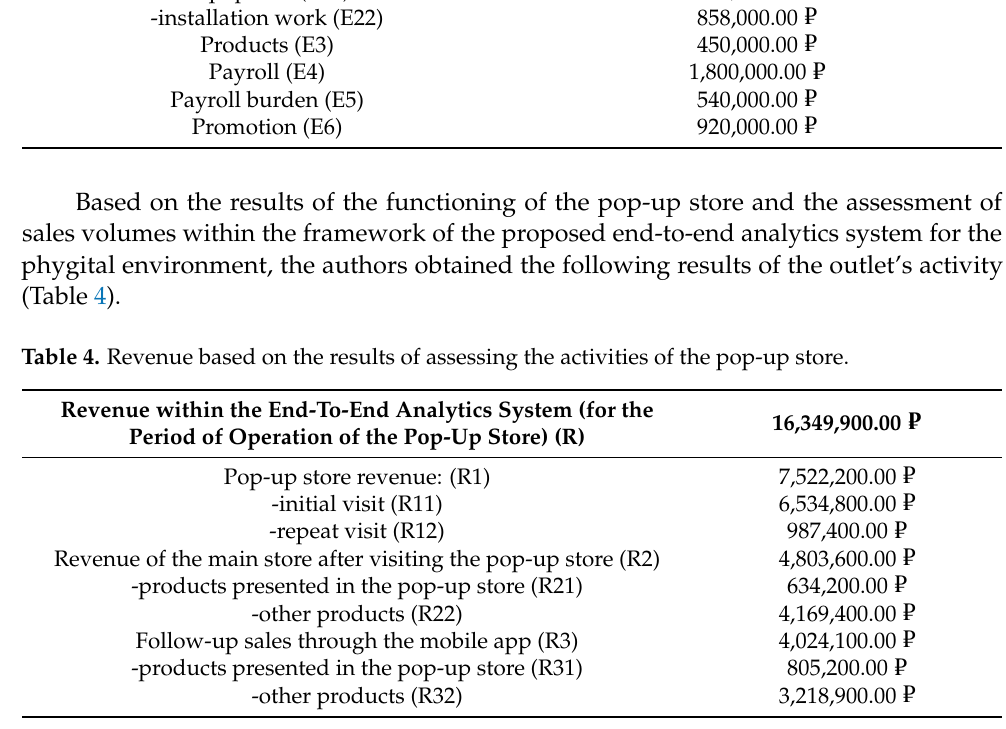
Table 3. Expenses of opening a pop-up store.